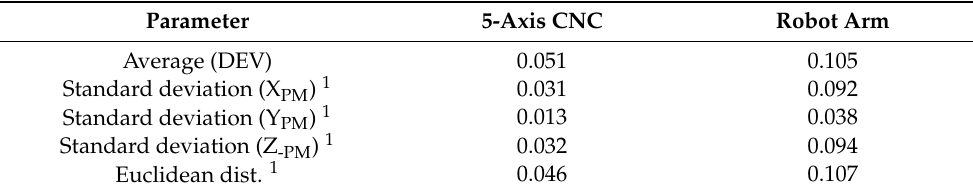
Table 5. Comparison of the calibration results in the case of using a 5-axis CNC machine and robot